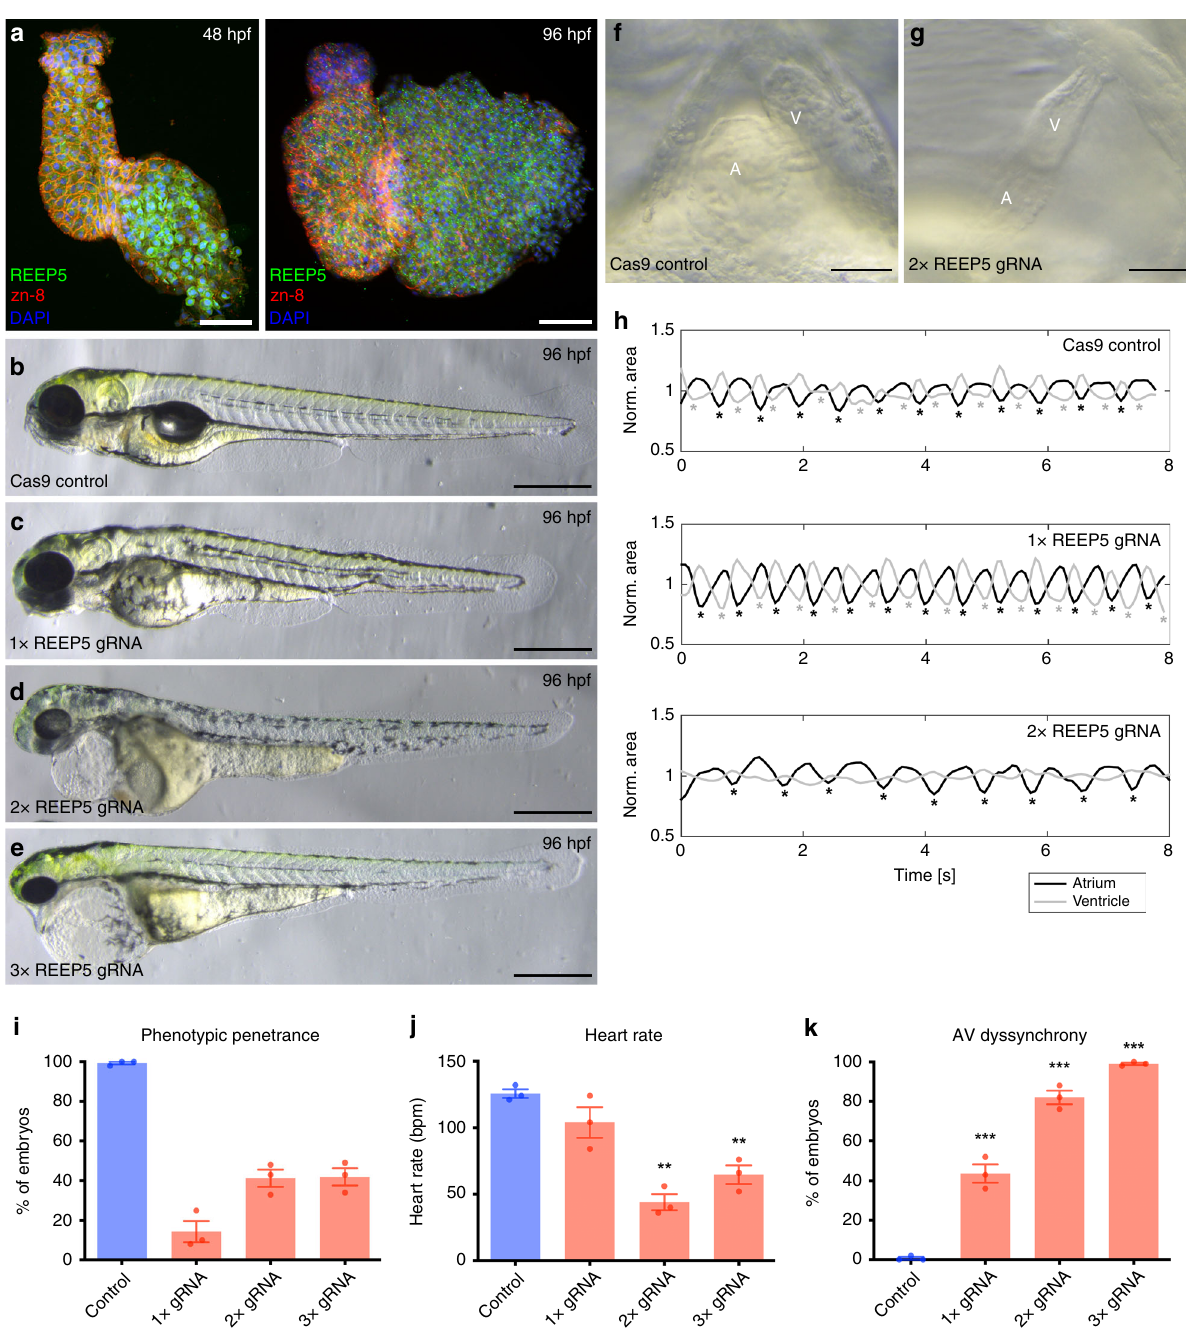
Fig. 7 In vivo CRISPR/Cas9-mediated REEP5 depletion in zebra fi sh embryos leads to cardiac abnormalities. a Immuno fl uorescence analysis of REEP5 expression in wild-type zebra fi sh hearts at 48 and 96 hpf. Co-staining for REEP5 (green), zn-8 (general plasma membrane; red) and DAPI (nuclear; blue) revealed REEP5 expression in both ventricular and atrial cardiac myocytes, with no nuclear or membrane localization evident. Scale, 50 μ m. b – e CRISPR/ Cas9-mediated depletion of REEP5 with varying gRNA concentrations reveals the contribution of REEP5 to embryonic heart development in zebra fi sh embryos. Images shown are representative of 331 control, 410 2× REEP5 gRNA, and 296 3× REEP5 gRNA total injected embryos, n = 3 independent biological replicates. Scale, 500 μ m. f , g Optical imaging analysis of control and 2× REEP5 gRNA injected embryos shows cardiac looping defects associated with REEP5-targeted gRNA injection. Scale, 10 μ m. h Movie analysis of REEP5 gRNA injected embryos shows dyssynchronous atrio-ventricular beating rhythms compared to control zebra fi sh embryos. Area pro fi les were smoothened with a Gaussian curve with σ = 0.2 s. i – k Bar graphs showing i phenotypic penetrance represented as percentage, j heart rate represented as beats per minute (bmp), and k atrioventricular beating dyssynchrony represented as percentage from 331 control, 410 2× REEP5 gRNA, and 296 3× REEP5 gRNA total injected embryos, n = 3 independent biological replicates. Asterisks indicate a statistically signi fi cant p value in a Tukey ’ s multiple comparison analysis where * p < 0.05, ** p < 0.01, and *** p < 0.001; data are presented as mean ±